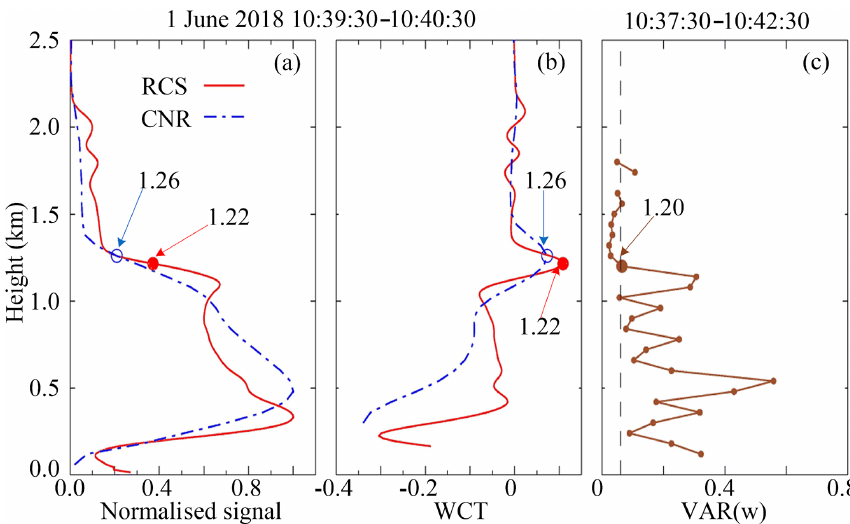
Figure 2. (a) The 1min mean normalised RCS and CNR profiles. (b) The corresponding HWCT results of the RCS and CNR profiles in (a) . (c) The vertical velocity variance profile. The dashed black line indicates the threshold of 0.06m 2 s − 2 . The red solid circle, blue circle and brown solid circle denoted by the arrows indicate the retrieved BLH, with the values at the end of the arrows.